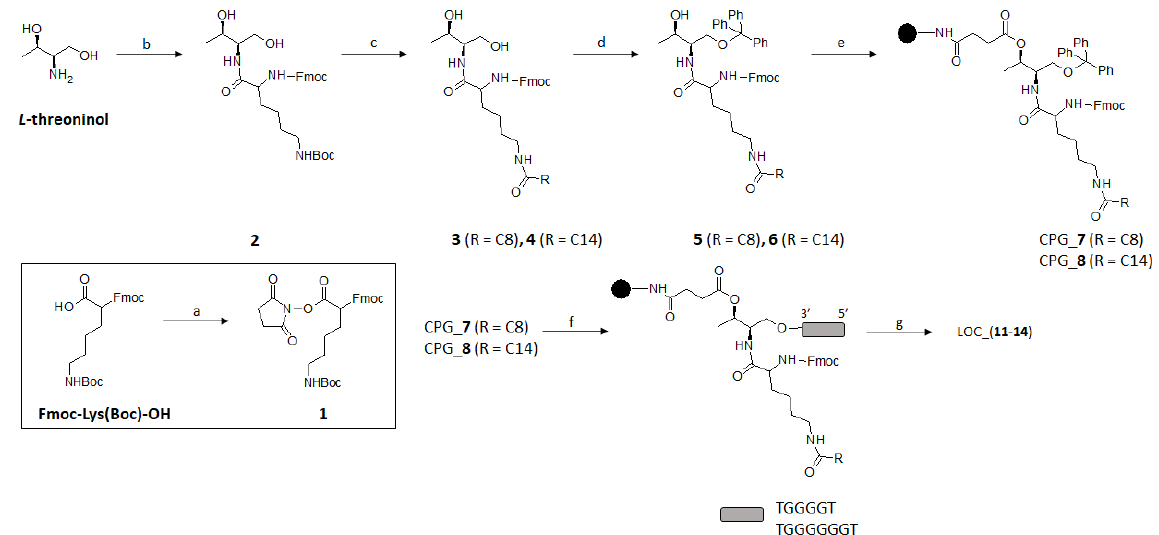
Figure 2. Synthetic route devised to obtain CPG solid supports modified with octyl and tetradecyl alkyl chains and lipid oligonucleotide conjugates (LOCs). Reagents and conditions: a. NHS, EDCI, DCM, r.t.; b. ( 1 ), DMF, r.t., overnight; c. (i) DCM:TFA 10%, r.t., 30 min; (ii) AcONa 50% w/v , THF:H 2 O (1:1), RCOCl (R = octyl chloride or tetradecanoyl chloride, r.t., overnight; d. TrCl, DIPEA, pyridine, 45 ◦ C, overnight; e. CPG functionalization; f. aq. NH 3 (32%), 55 ◦ C, overnight; g. (i) HPLC purification; (ii) AcOH 80%, 30 min, r.t.; (iii)